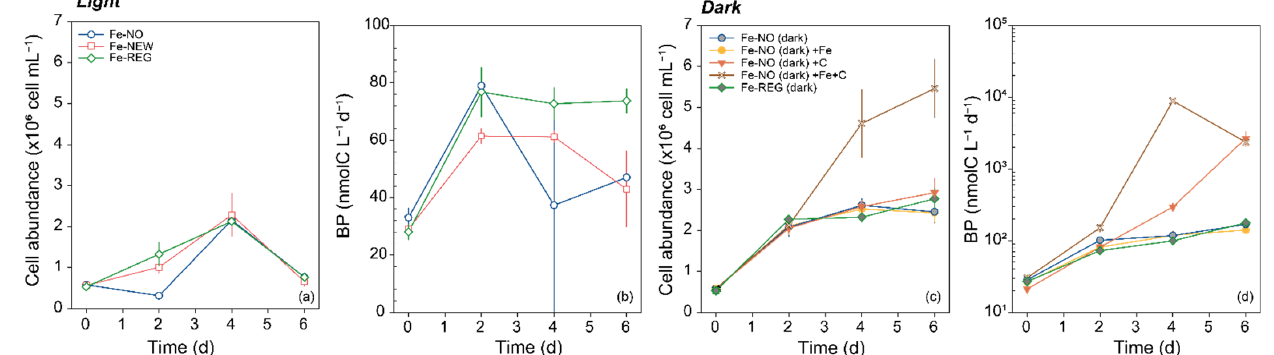
Figure 5. Time course of ( a ) bacterial cell abundance and ( b ) bacterial production (BP) in Fe-NO, Fe-NEW and Fe-REG treatments for incubation under natural daylight cycle and 73 ± 5% of surface irradiance (empty symbols). Time course of ( c ) bacterial cell abundance and ( d ) BP in the dark (filled symbols) for Fe-NO and Fe-REG, and for Fe-NO amended with Fe (brown color, Fe-NO (dark) +Fe),with carbon (orange color, Fe-NO (dark) +C), and both elements (yellow color, Fe-NO (dark) +Fe+C). Note the logarithmic scale for the y -axis in ( d ). Error bars represent the standard deviation of triplicate incubation bottles.